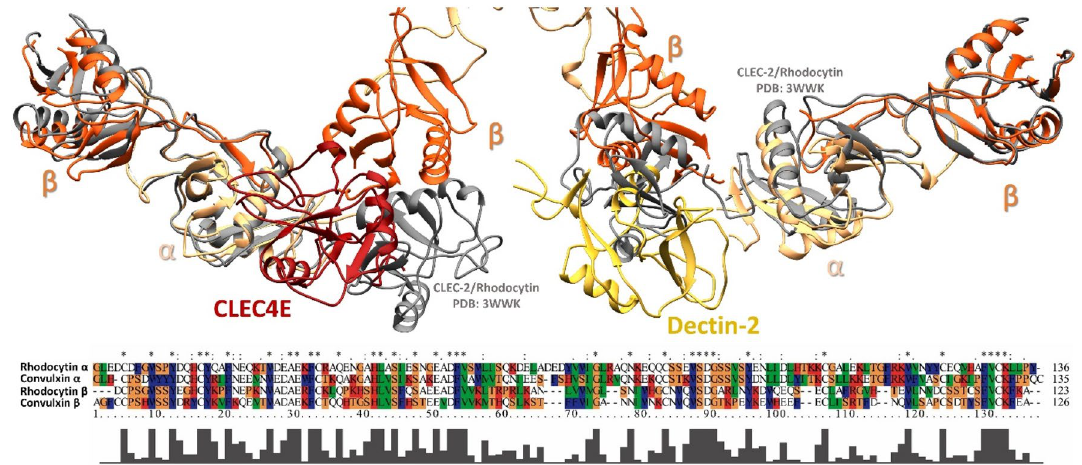
Figure 9. Superposition of Rhodocytin in complex with CLEC-2 (gray) crystal structure (PDB: 3WWK) and the complexes predicted for the interactions between CVX (β subunits in orange and α subunits in sandy brown) and the CTLRs CLEC4E (red) and Dectin-2 (yellow).